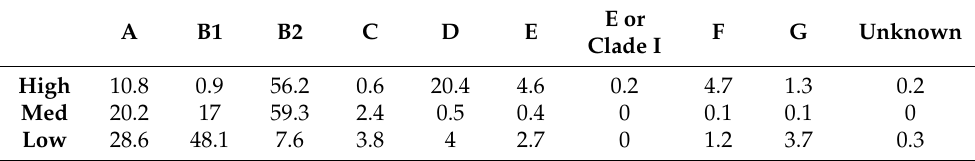
Table 3. Distribution of relative risk group by E. coli phylogenetic